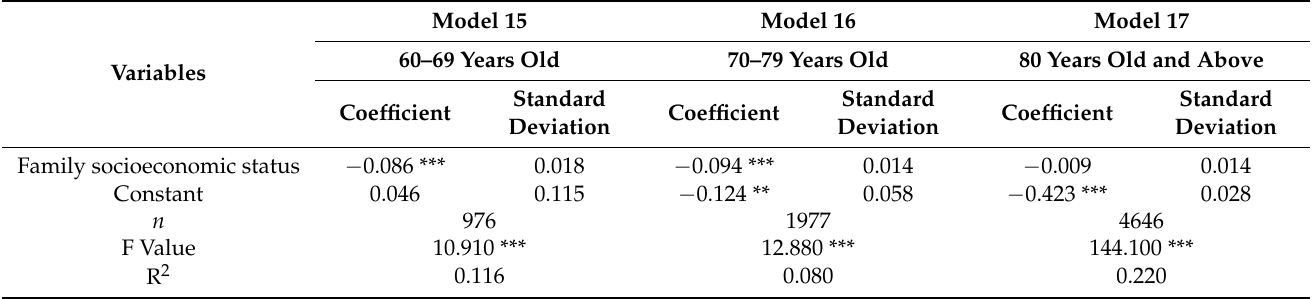
Table 5. Results of multiple linear regression (with explanatory variable) by